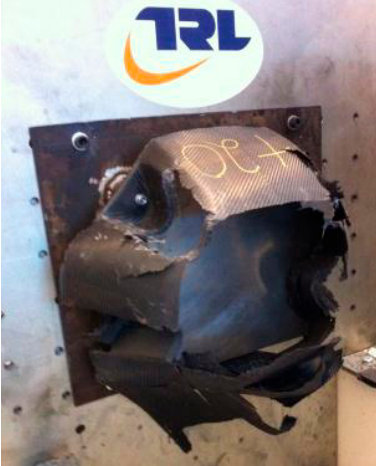
Figure 9. Carbon fiber nose cone after impact [18].